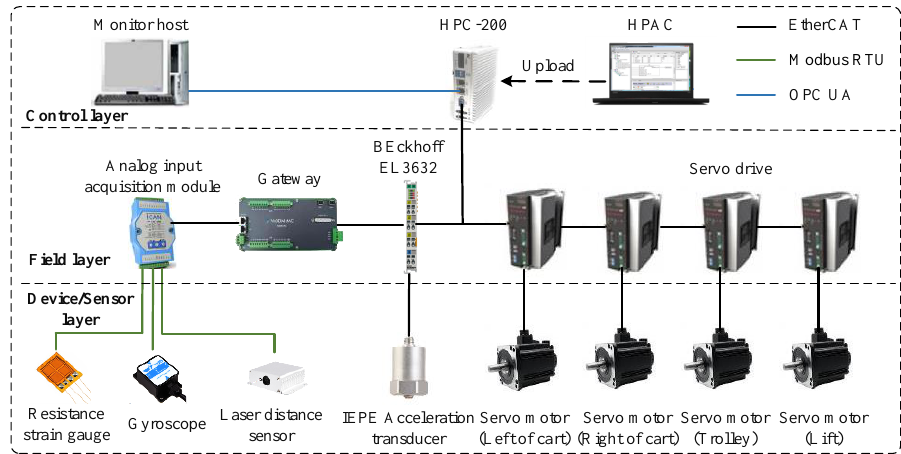
Figure 3. System architecture diagram of the physical platform.